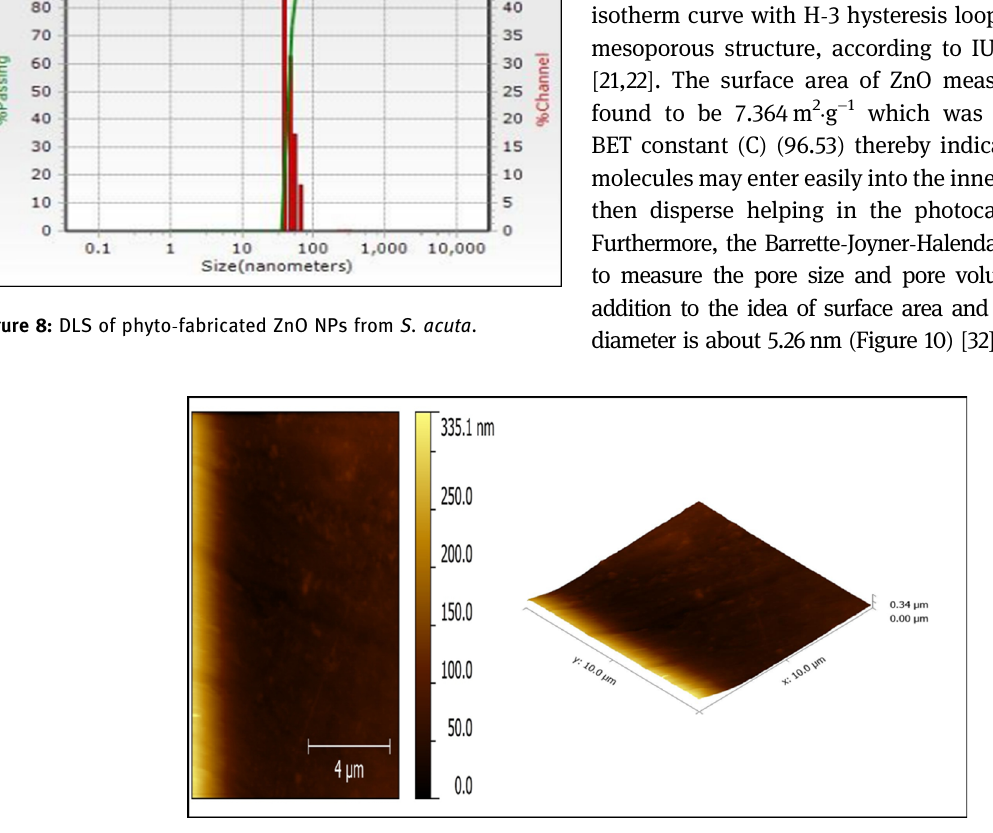
Figure 9: AFM images of phyto - fabricated ZnO NPs from S. acuta .